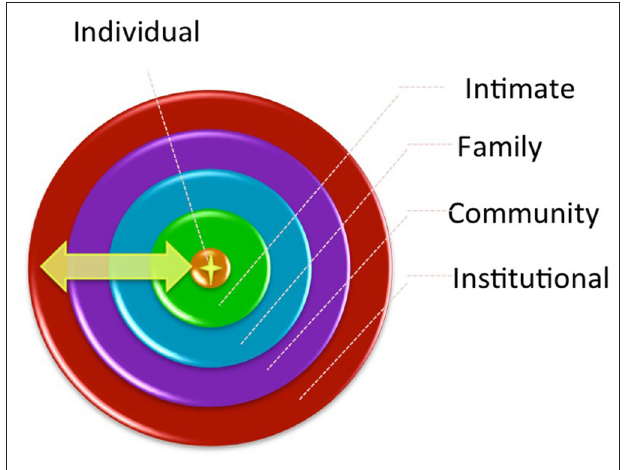
FIGURE 1 | Young women and men’s social relationships at various levels of their social environment (